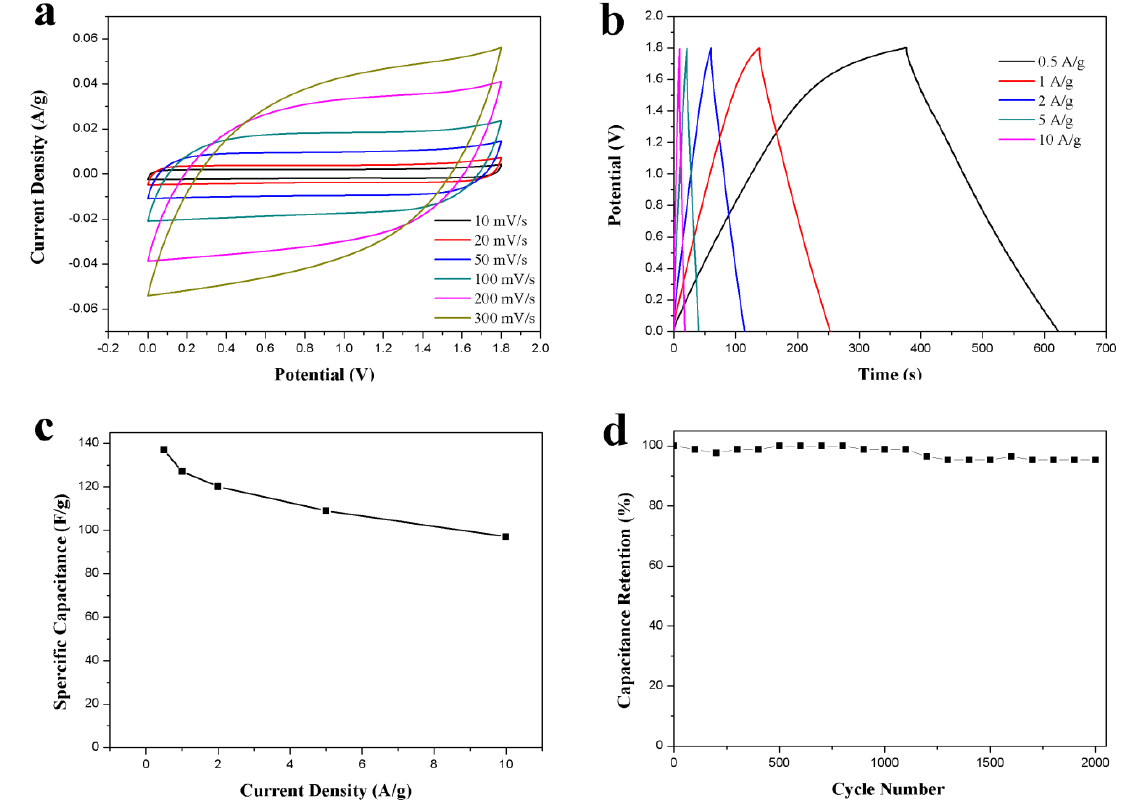
Figure 6. Electrochemical performance of the ACS-ZnCl 2 in symmetric supercapacitor in 2 M Li 2 SO 4 electrolyte. ( a ) CV curves tested at different scan rates, ( b ) GCD curves and ( c ) specific capacitances at different current densities, and ( d ) cycle stability for 2000 cycles at a current density of 10 A/g.